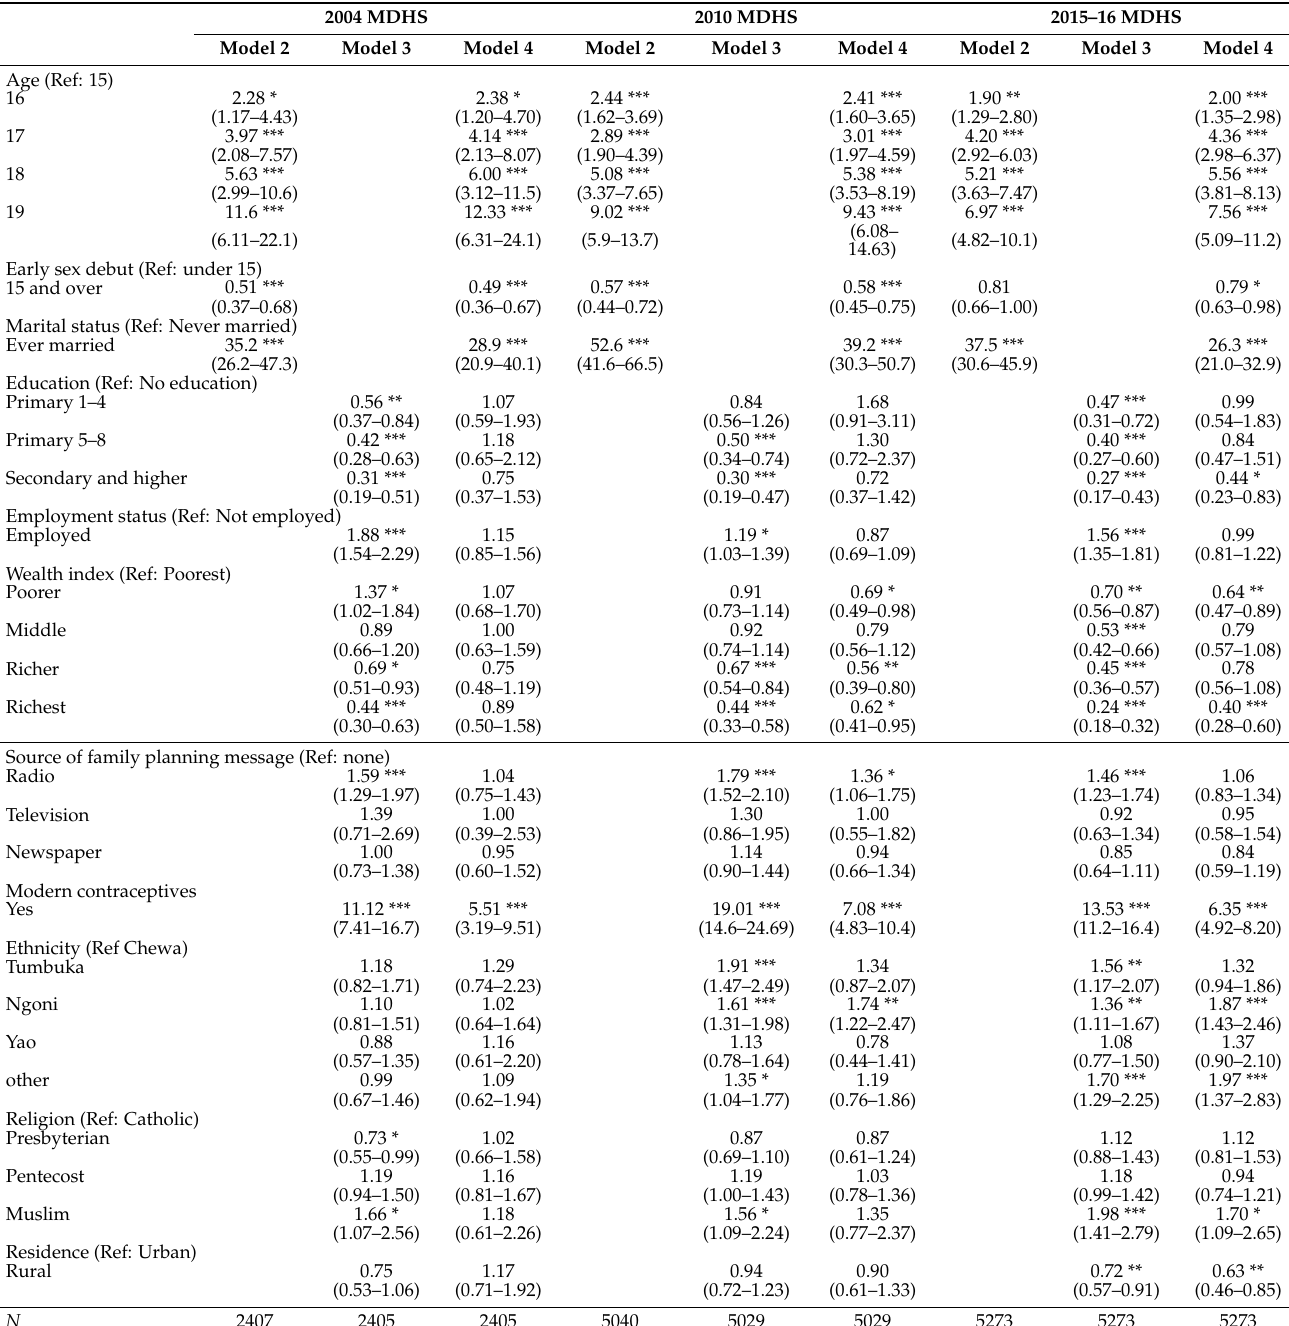
Table 4. Odds ratios and 95 percent confidence intervals for demographic, socioeconomic and community variables associated with teenage childbearing in Malawi from 2004 to